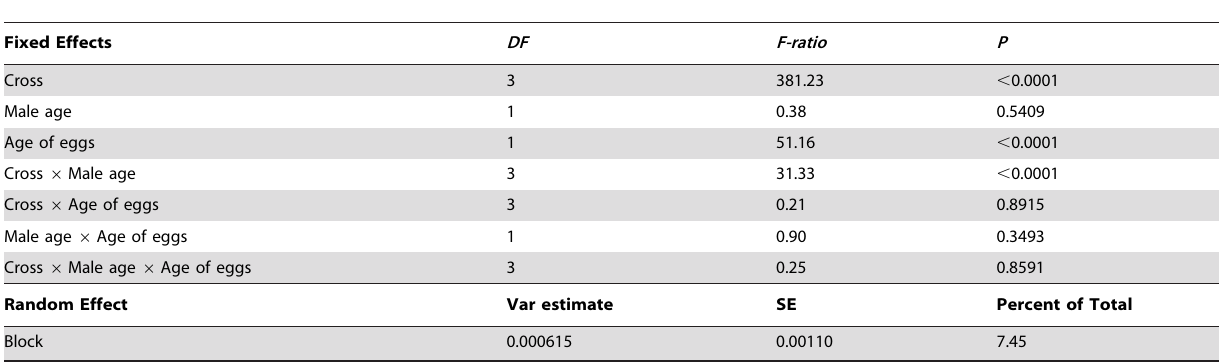
Table 1. Analysis of variance of egg hatching rate.